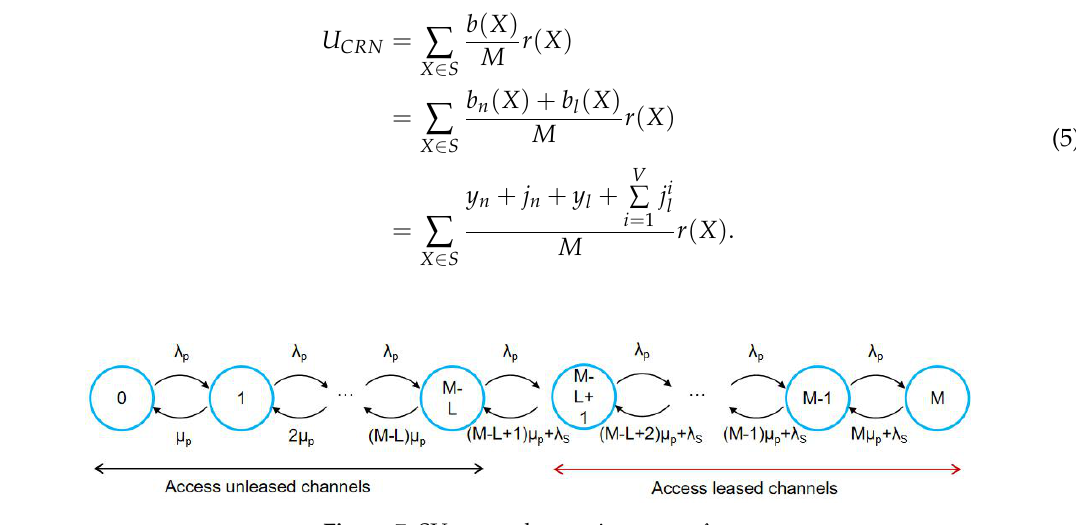
Figure 7. SU network capacity versus λ P . Table 1. Transitions of DFSL when a PU arrives.